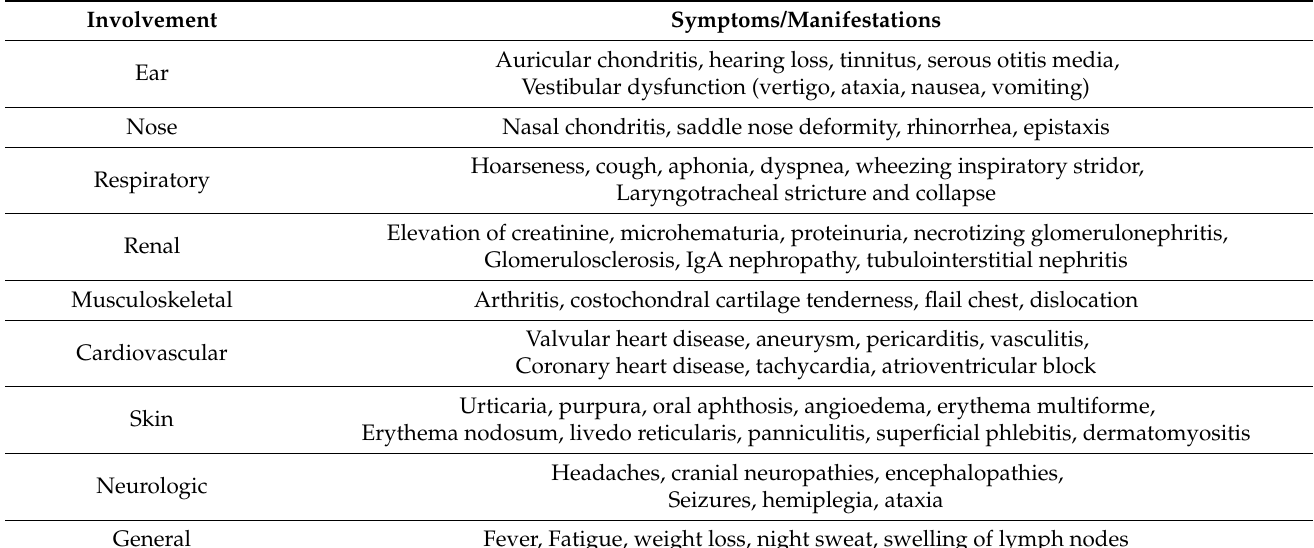
Table 5. Clinical systemic manifestation of RPC.